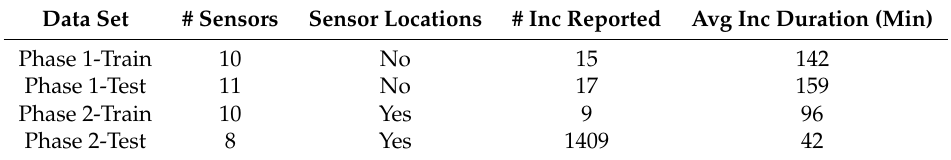
Table 2. A summary of the four traffic data sets to which we applied the incident detection